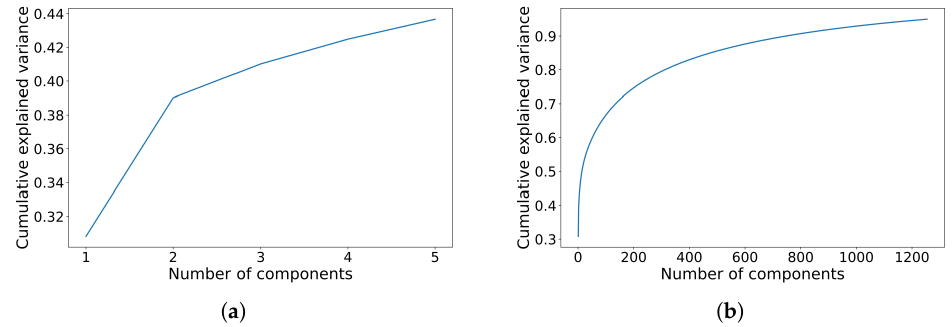
Figure 8. PCA analysis showing ( a ) cumulative explained variance by 5 principal components, ( b ) number of components required to explain 95 % of the cumulative variance.